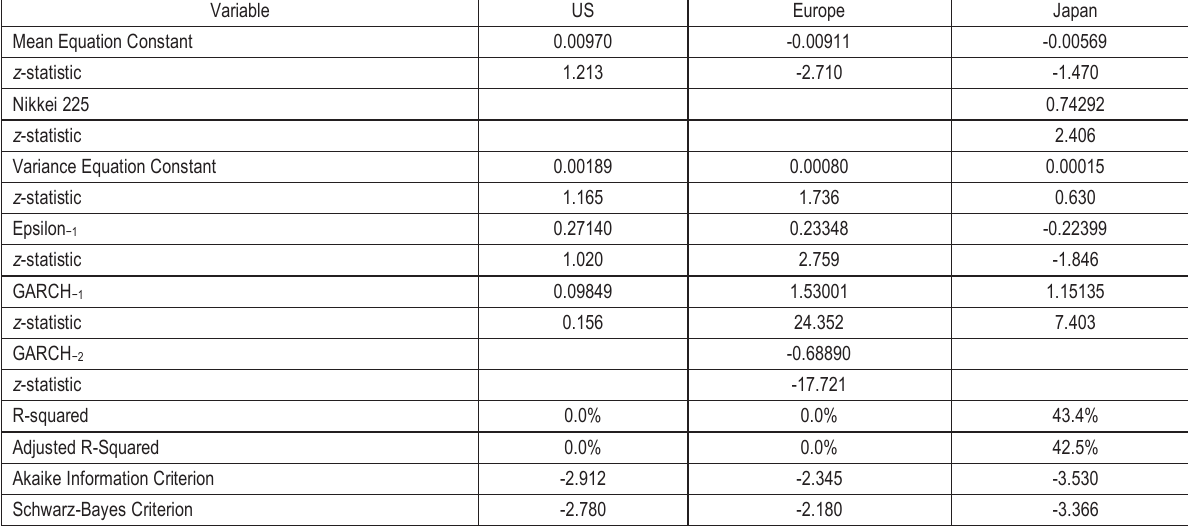
Table 10. Conditional Variance of Bank Stock